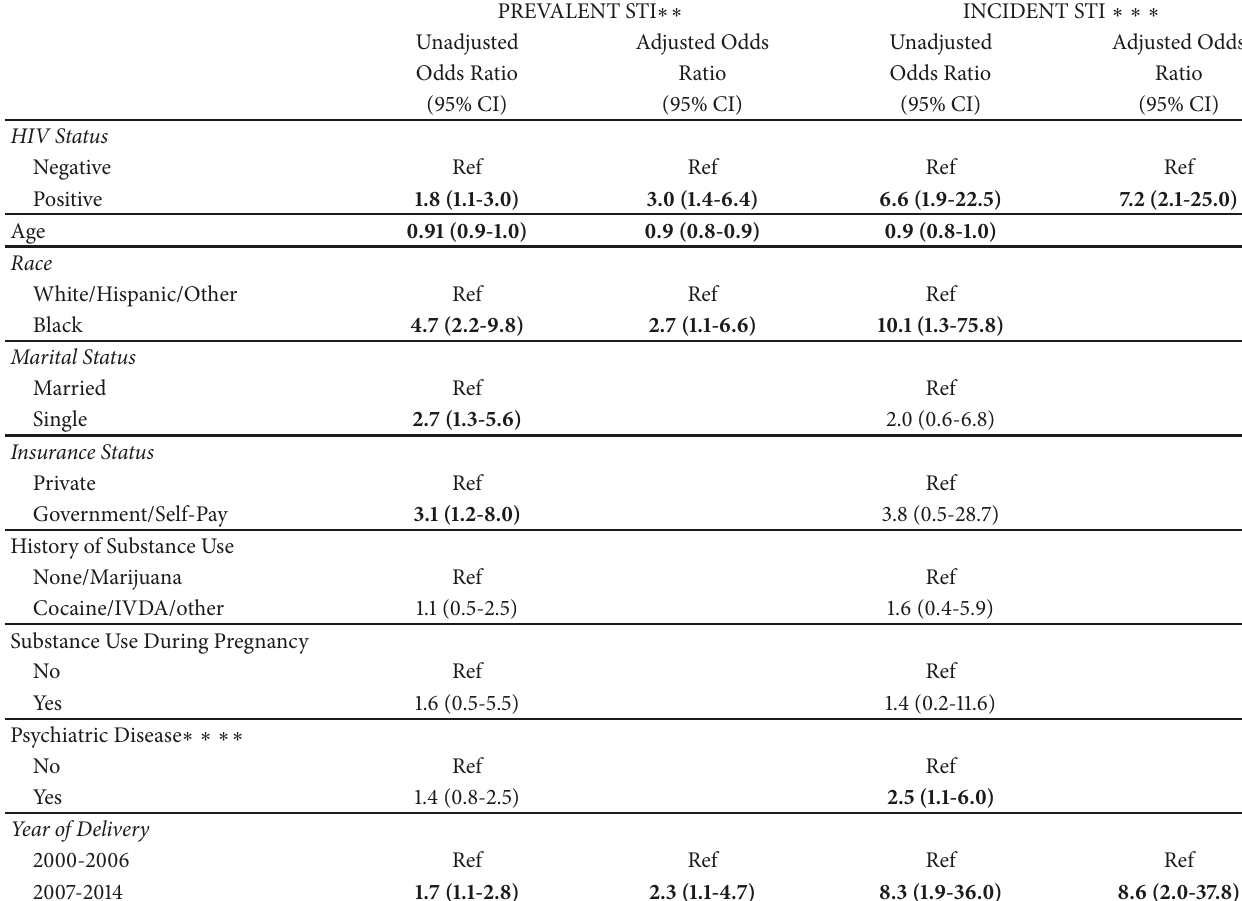
Table 3: Factors associated with prevalent and incident STI in pregnancy ∗ . PREVALENT STI